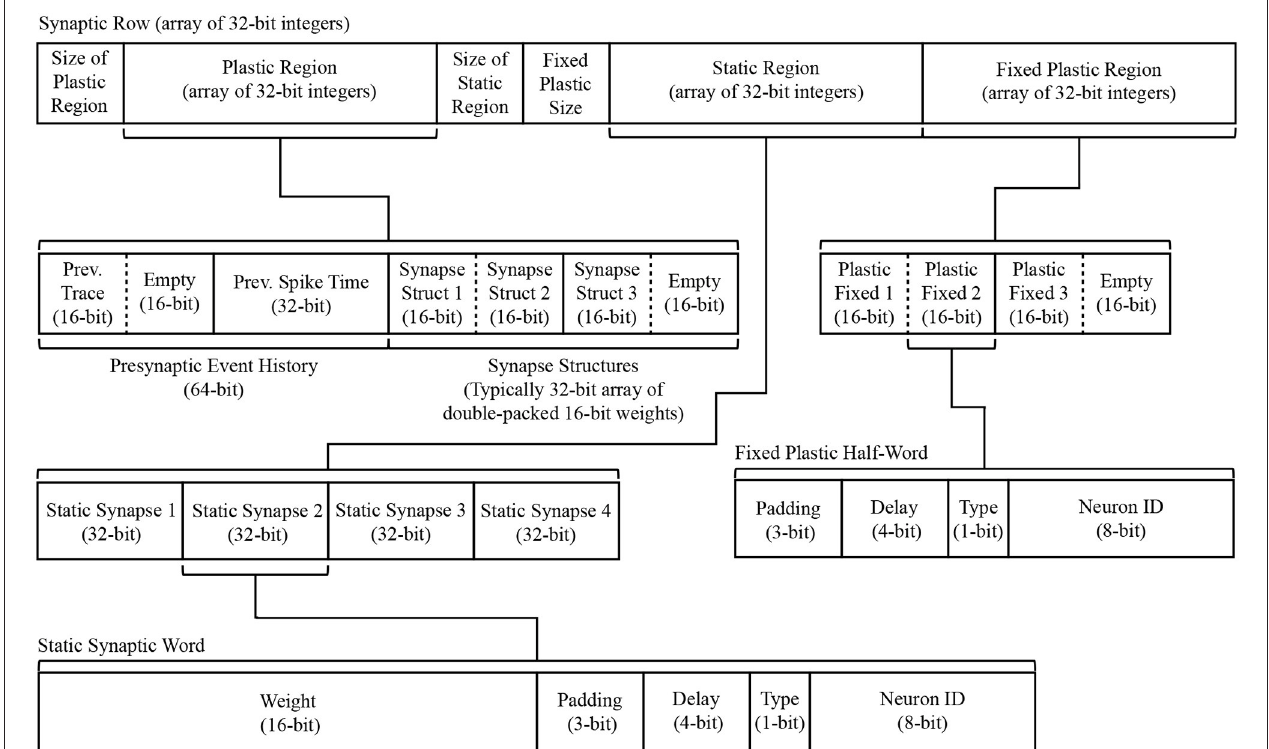
FIGURE 8 | Synaptic row structure with breakdown of substructures for both static and plastic synapses.